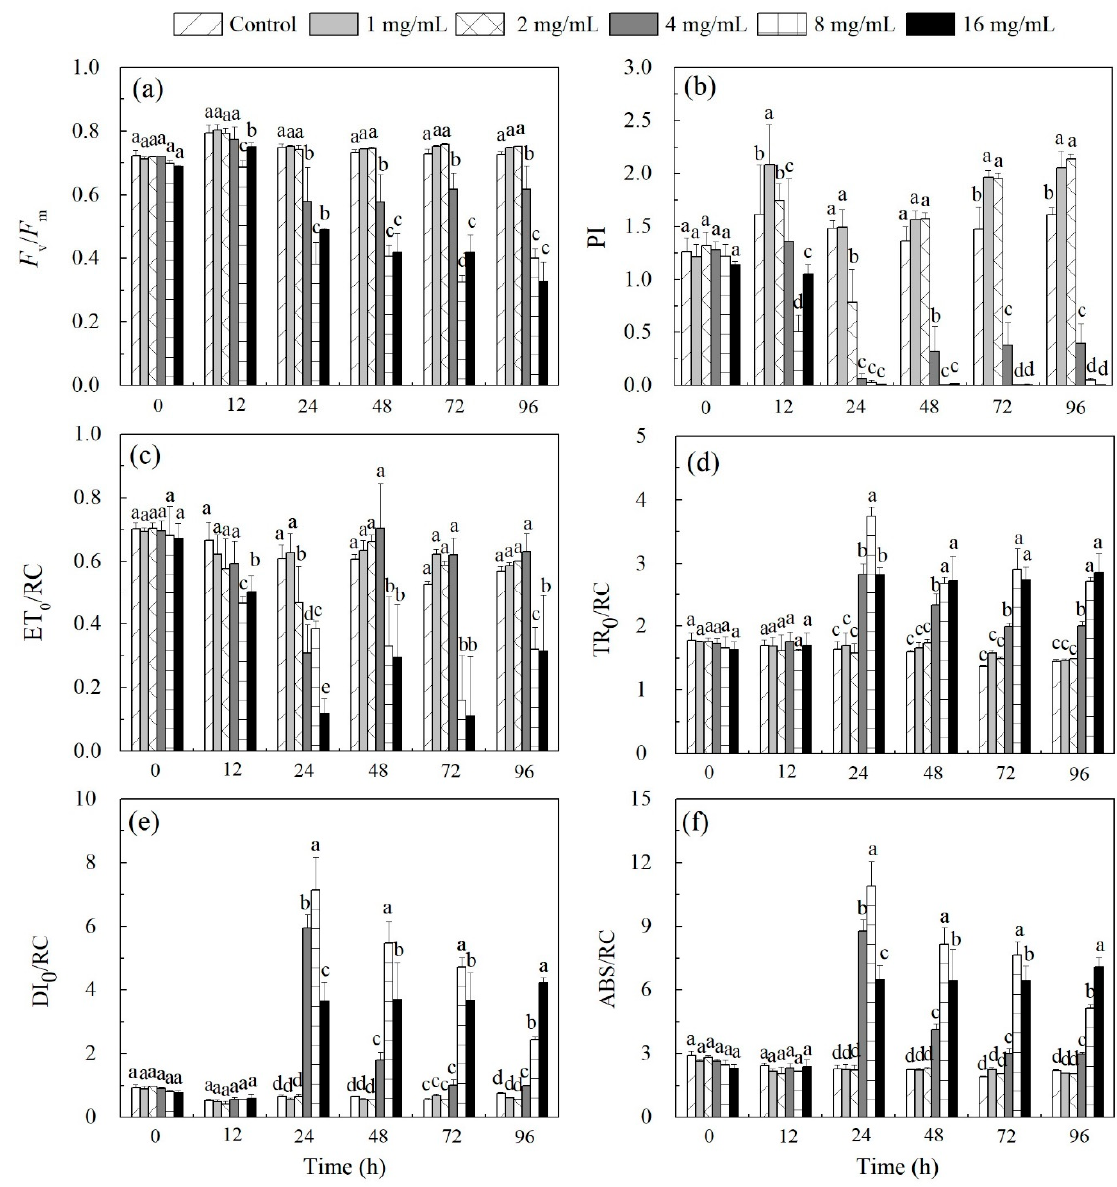
Figure 3. The bar graph of JIP-test parameters induced by C. rotundus aqueous extracts on photosynthetic efficiency ( F v / F m ) ( a ), performance index (PI) ( b ) and specific energy fluxes per active PSII reaction center (including ET 0 /RC, TR 0 /RC, DI 0 /RC and ABS/RC) ( c – f ). The data are presented as mean ± standard deviation ( n = 4). Different letters indicated statistically significant differences among different groups at the same experimental time ( p < 0.05).